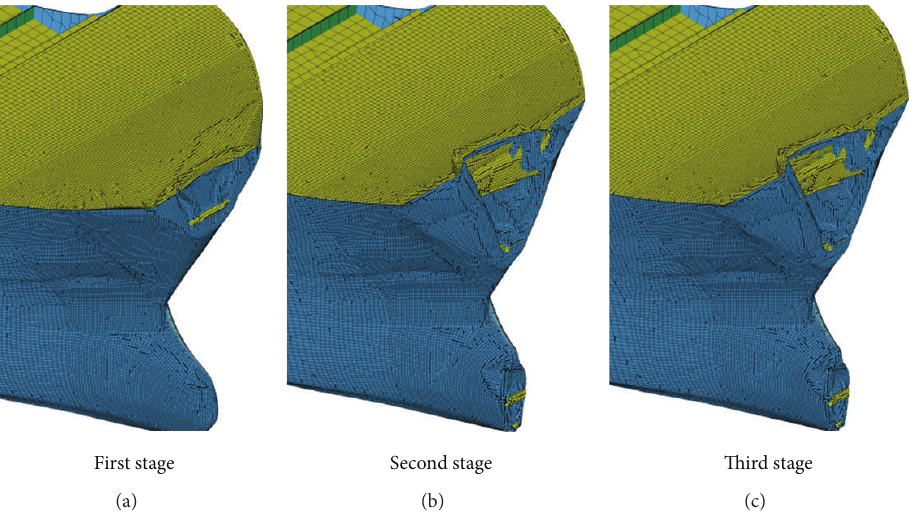
Figure 5: Dynamic process of the vessel-bridge collision.